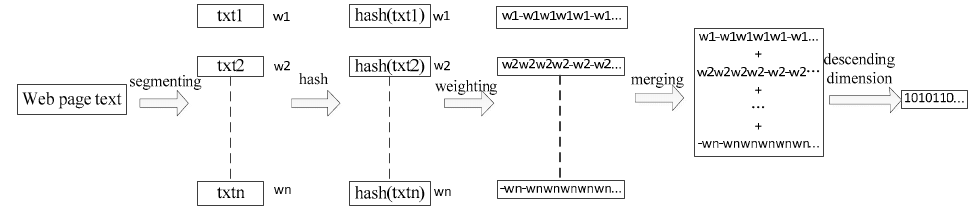
Figure 2. The process of the simhash algorithm.